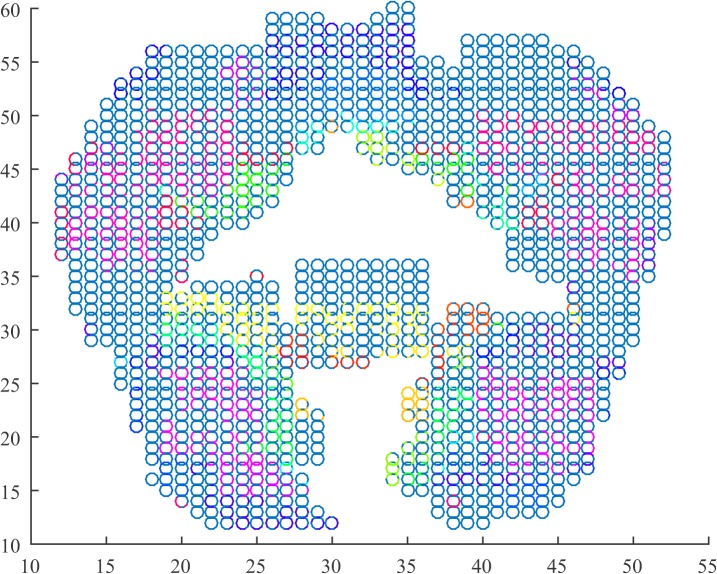
Cluster depiction in the coronal view (z = 0) of the cortex during symbol arrangement.Clusters identified by the regularity partitioning algorithm as seen on the coronal view obtained by the examined fMRI data. Each cluster is colored with a different color. During this epoch, the subject was exposed to the arrangement of symbols that was connected with the question in the first epoch.